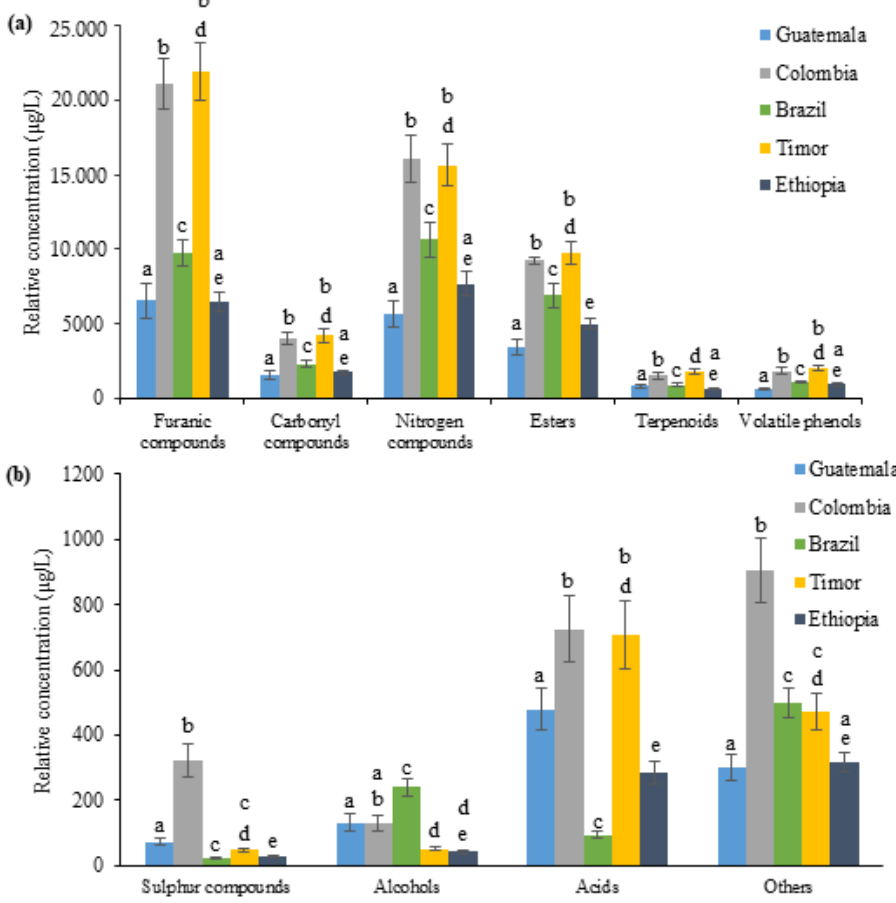
Figure 3. Relative concentration ( µ g/L) of the volatile organic metabolites identified grouped by major ( a ) and minor ( b ) chemical families for the spent coffee grounds. Different superscript letters in the same chemical family indicate significant differences ( p < 0.05) among spent coffee grounds from different geographical origins.